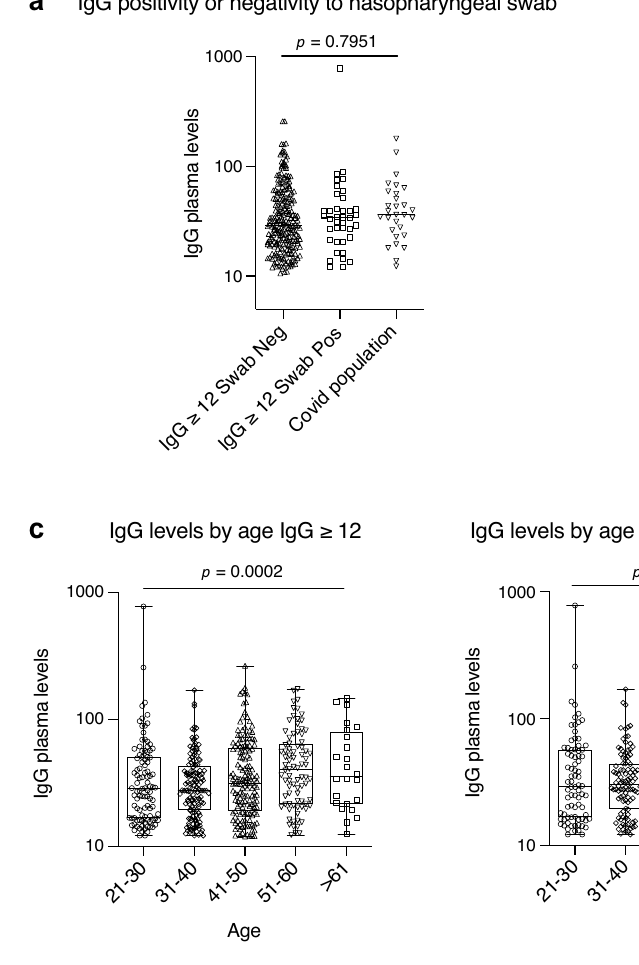
Figure 4. Distribution of IgG plasma levels in the different populations. ( a ) Distribution of IgG plasma levels in the cohort of IgG positive individuals (IgG ≥ 12 AU/mL) negative or positive for the nasopharyngeal swab or ascertained COVID-19 disease. ( b ) Distribution of IgG plasma levels in IgG positive individuals (IgG ≥ 12 AU/mL) divided by sex. ( c ) Distribution of IgG plasma levels in IgG positive individuals (IgG ≥ 12 AU/mL) divided by age ranges and sex. In ( a ) and ( b ) p -values were determined using Cochran Mantel-Haenzel test for trend. In ( c ) Cuzick’s test for trend was used: p = 0.0002 (total); p = 0.0085 (female); p = 0.008 (male); p = 0.4192